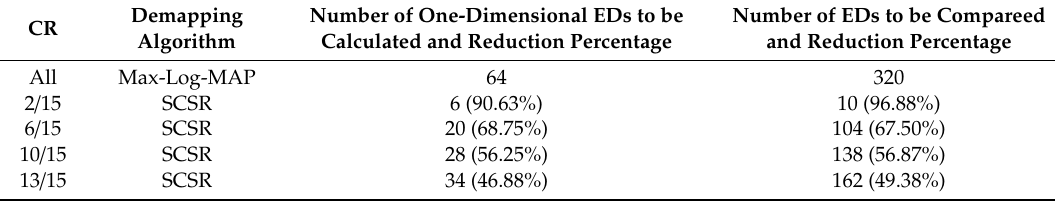
Table 2. Complexity comparison when demapping